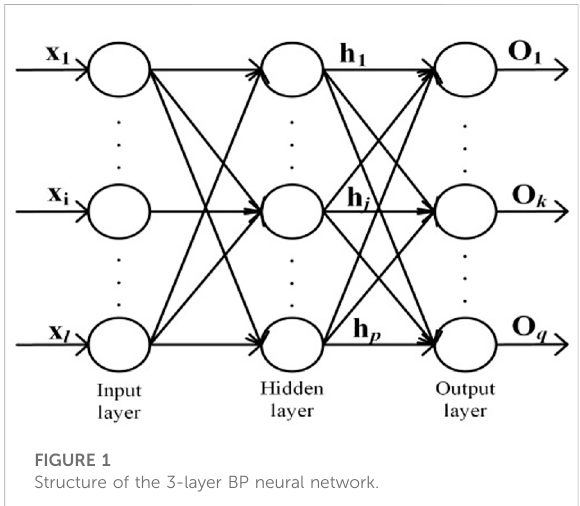
FIGURE 1 Structure of the 3-layer BP neural